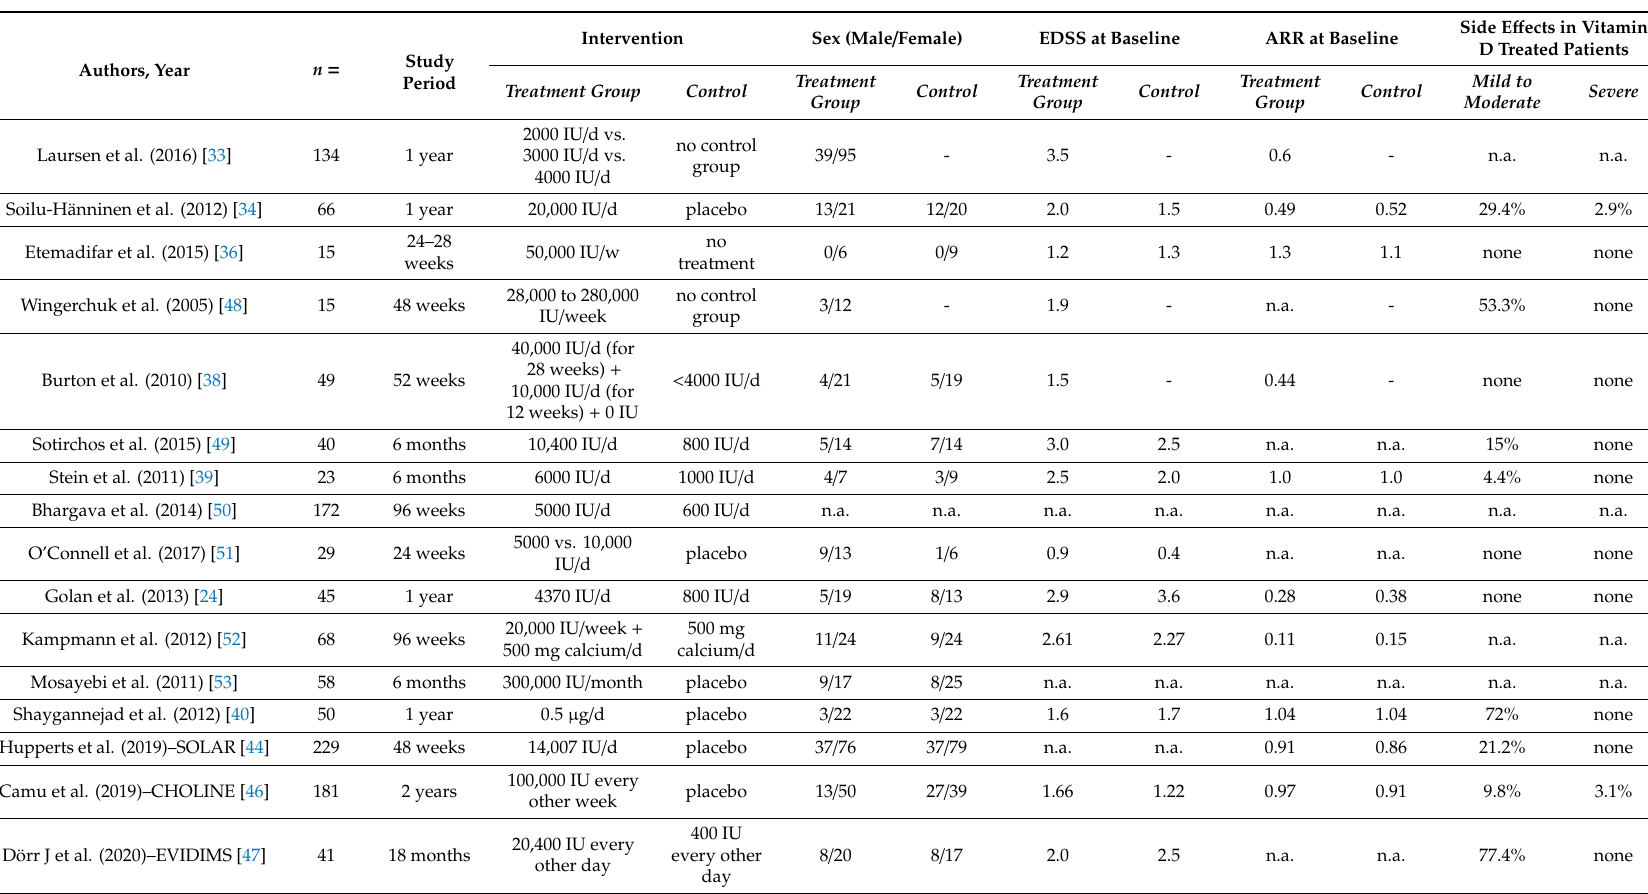
Table 1. Characteristics of studies assessing e ffi cacy and safety of vitamin D supplementation. IU: international units. EDSS: expanded disability status scale. ARR: annualized relapse